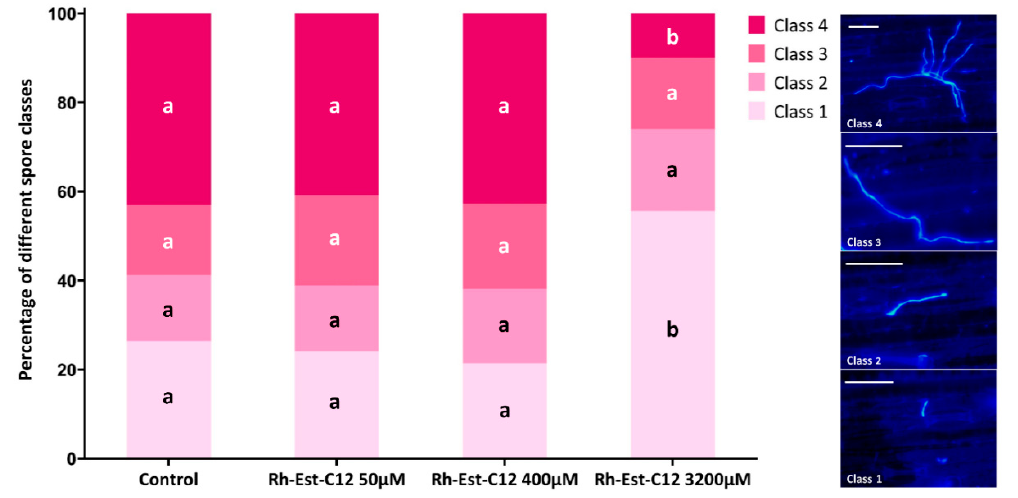
Figure 3. In planta spore germination and hyphal growth of Zymoseptoria tritici on wheat leaves treated or not with Rh-Est-C12. Wheat cultivar Alixan and Z. tritici strain T02596 were used. Percentage of four different classes of Calcofluor-strained spores was assessed three days after inoculation on wheat third leaves. The right panel shows a representative picture of each spore class (scale bar = 25 μ m). Class 1: non germinated spore; Class 2: geminated spore with small germ tube; Class 3: geminated spore with developed germ tube; Class 4: geminated spore with a strongly developed germ tube. For each condition, 100 different spores from six different leaves were assessed. Within each class, different letters indicate significant differences between treatments according to ANOVA followed by the Tukey’s test at p ≤ 0.05.